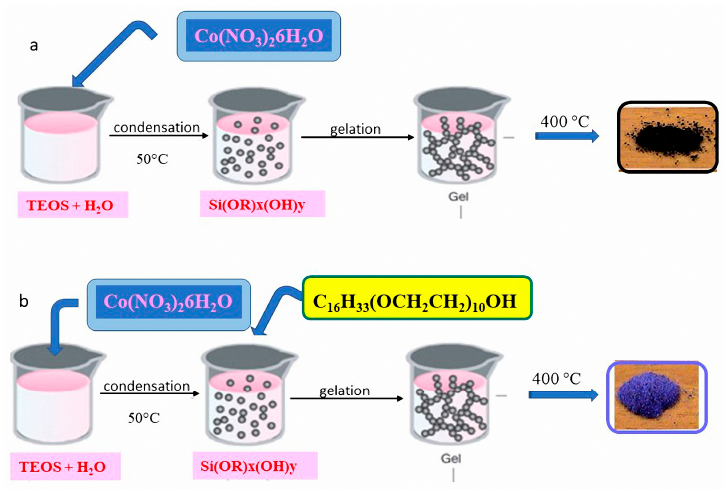
Figure 8. Schematic representation of the synthesis of CoO x –SiO 2 by ( a ) hydrolytic alkoxide sol-gel route and ( b ) non-ionic surfactant assisted sol-gel route.